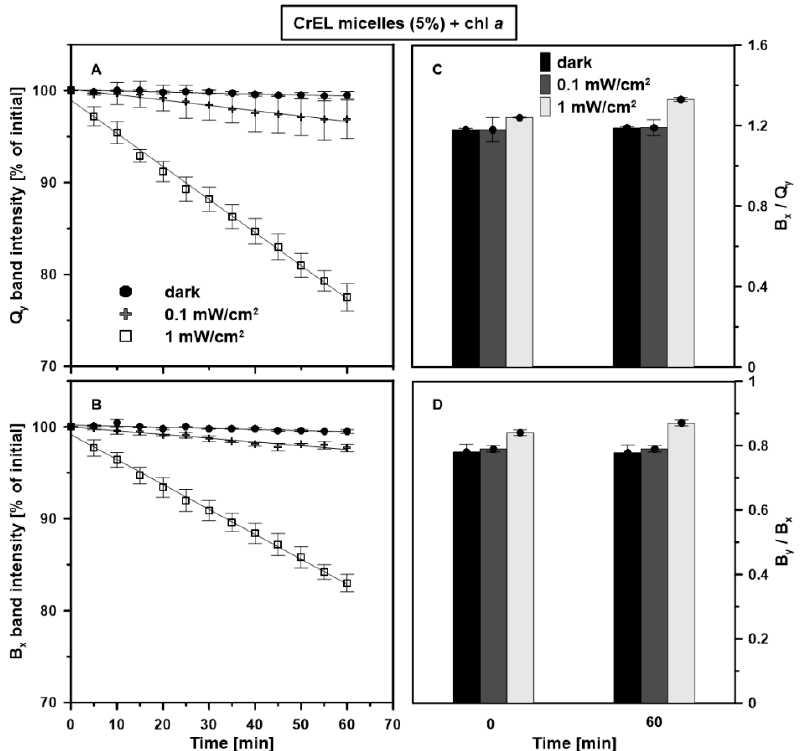
Figure 6. Photostability of chl a in the CrEL nano-micelles. Stability was expressed as the Q y and B x bands intensity (panels: A , B ), B x / Q y and B y / B x ratios (panels: C , D ) varying with illumination for 60 min. The molar concentration of chl a was 10 − 5 M. The samples were dark-adapted for 60 min (black circles) or illuminated with white light for 60 min. The power of light was 0.1 mW / cm 2 (grey crosses) or 1 mW / cm 2 (white squares). The experiment was repeated three times (biological replicates). The presented mean values ± SD are obtained on the basis of the absorbance spectra.